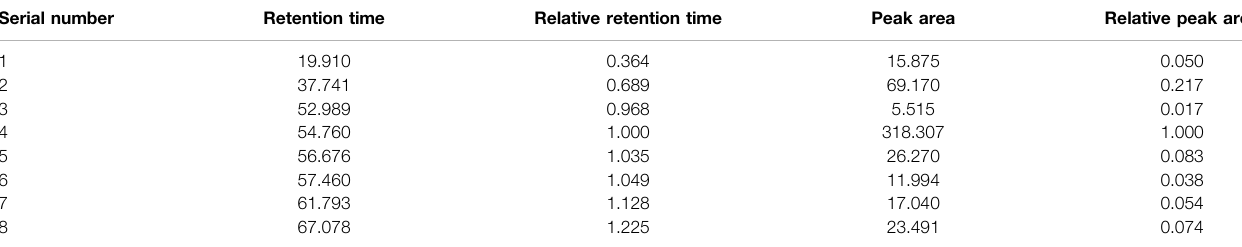
TABLE 6 | Parameters of common peaks of standard